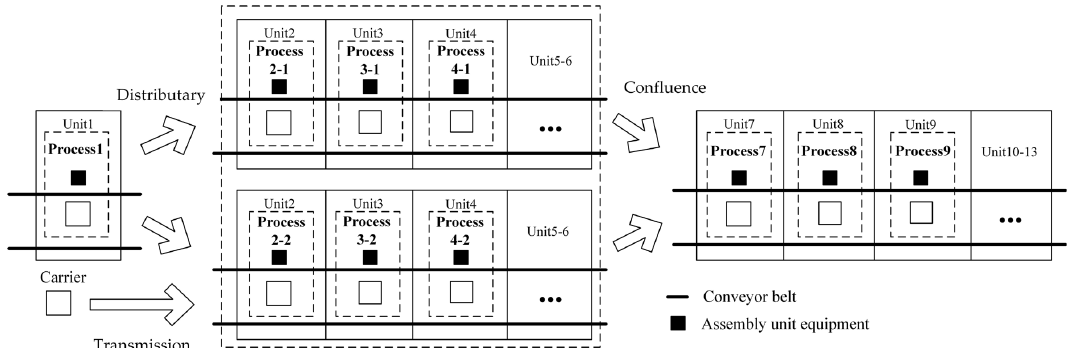
Figure 2. Traditional CBs semi-automatic production